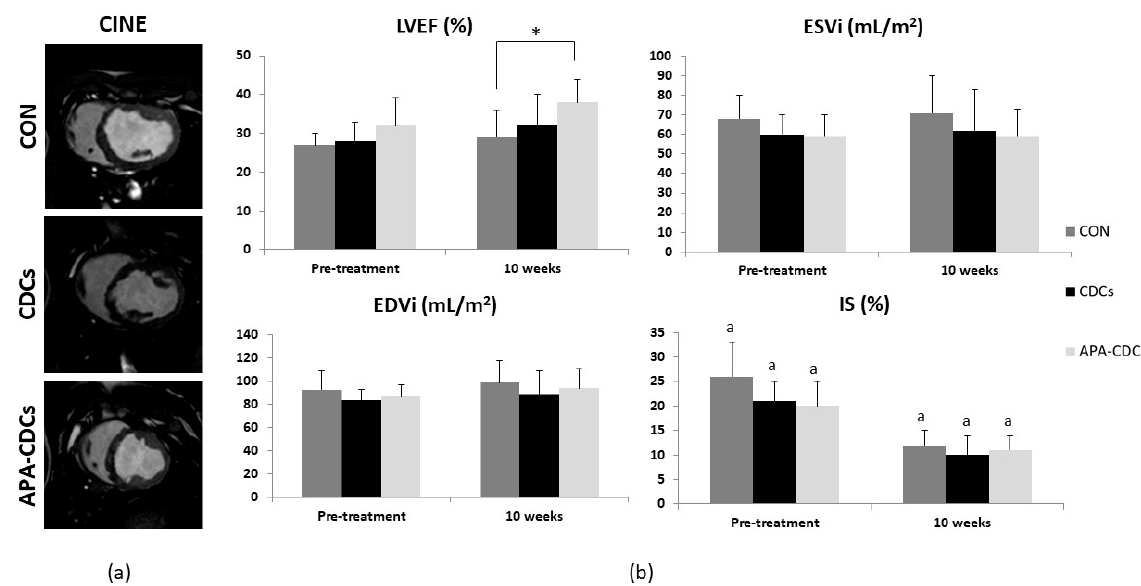
Figure 3. MRI results. ( a ) Representative cine images from the short axis view belonging to each group at 10 weeks. ( b ) Evolution of MRI-derived cardiac function parameters: LVEF, EDVi, ESVi and IS. Differences within groups are denoted by a p < 0.05 and those among groups by * p < 0.05.